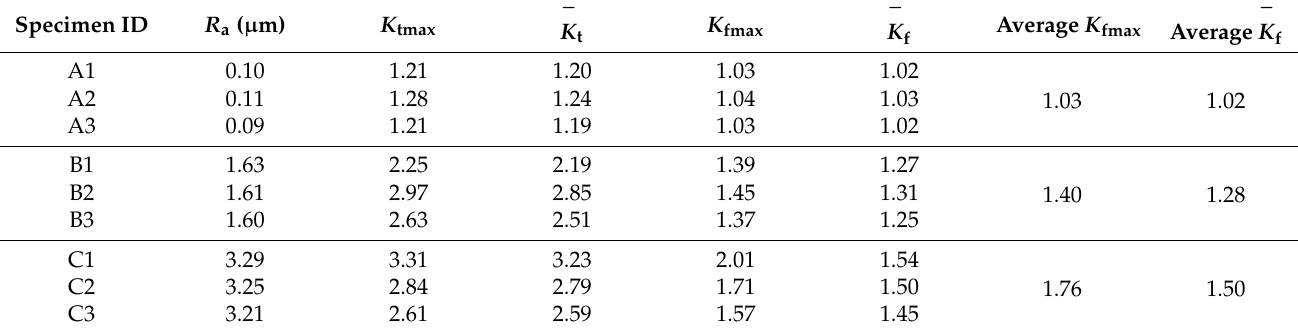
Figure 8. The SCFs and FNFs induced by surface topography for specimen B1. Surface topographies act as multi-notches to introduce stress concentration and affect the fatigue performance of specimens. By analogy with the characterization of surface roughness, the maximum SCF, K tmax , the effective SCF, K t by averaging the top 10 values, the maximum FNF, K fmax , and the effective FNF, K f , by averaging the top 10 values are defined as the characteristic parameters to represent the fatigue behavior of rough spec- 10 10 ∑ ∑ ( K ) ( K ) imens, where K t = 1 , K f = 1 . Figure 8 shows that the maximum t i f i max max 10 10 i = 1 i = 1 FNF, K fmax = 1.39, and the effective FNF, K f = 1.27. According to Equations (10)–(13), the SCFs and FNFs imposed by surface topographies of each specimen are calculated and shown in Table 6. It is clear that the SCFs are much higher than the FNFs of each specimen. Besides, the maximum FNF, K fmax , and the effective FNF, K f , increase gradually with the increase of the average roughness, R a . To quantitatively evaluate the effect of surface topography on the fatigue strength and fatigue life of rough specimens, the maximum FNF, K fmax , and the effective FNF, K f , for the same degree of surface roughness were averaged, which are shown in Table 6. Table 6. The SCFs and FNFs induced by surface topographies of